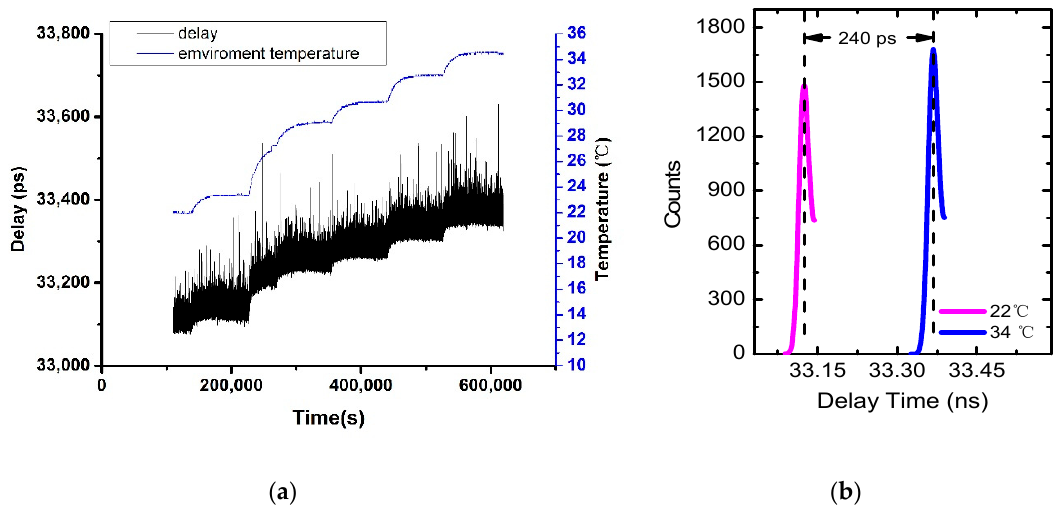
Figure 2. ( a ) The propagation delay and room temperature over time. ( b )The propagation delay drift of environment temperatures from 22 ℃ to 34 ℃ .